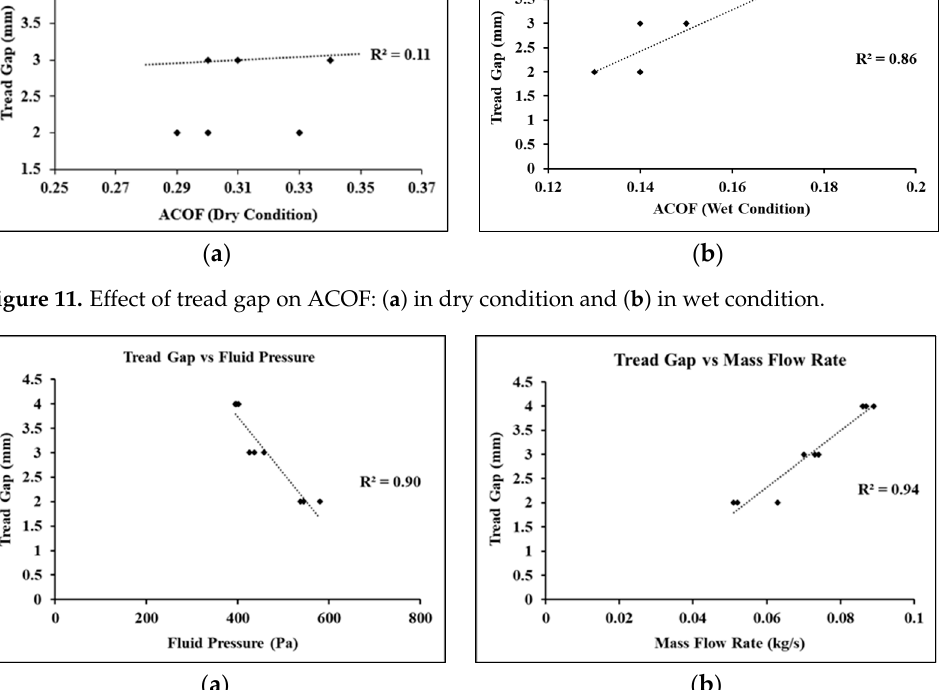
Figure 11. Effect of tread gap on ACOF: ( a ) in dry condition and ( b ) in wet condition.